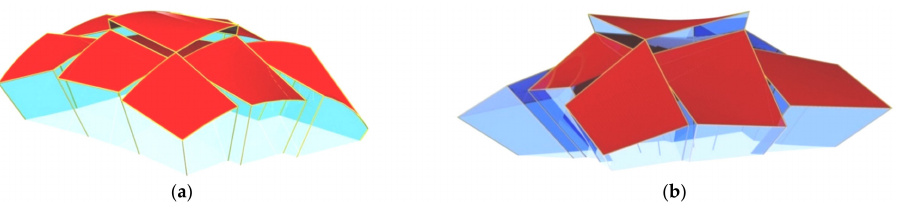
Figure 11. Complex building free-forms roofed with multi-segment shell structures and supported by ( a ) curved; ( b ) straight